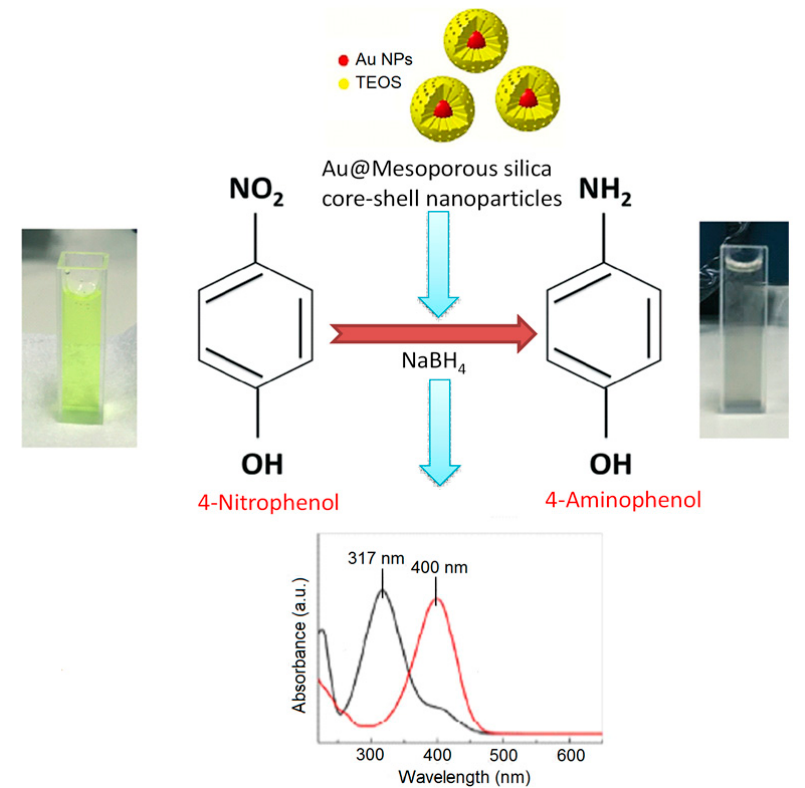
Figure 11. Catalytic reduction of 4-nitrophenol on Au@mesoporous silica core-shell nanoparticles.